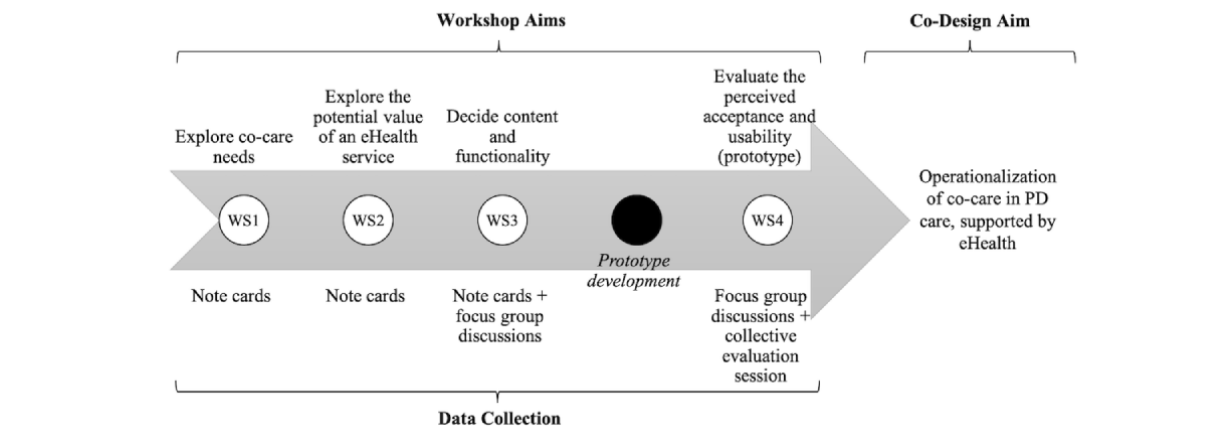
Figure 1. Overview of the co-design workshops performed to explore how people with Parkinson's disease (PD) and health care professionals would like to partner in chronic care management, with particular emphasis on how eHealth could support them. WS: